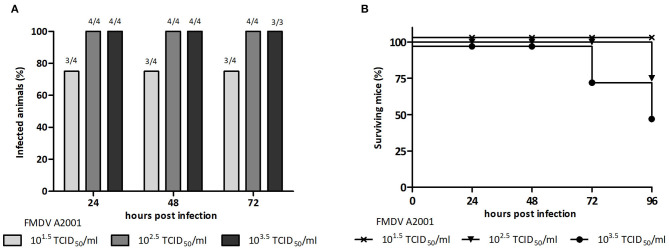
Selection of the infective dose of FMDV, serotype A. Groups of BALB/c mice (n = 4) were ip inoculated with 500 μL of 101.5TCID50, 102.5TCID50, or 103.5TCID50/mL of infectious FMDV A/Argentina/2001, and viremia was analyzed at 24, 48, and 72 hpi. (A) Percentage of infected animals at 24, 48, and 72 hpi and (B) percentage of surviving mice at 24, 48, 72, and 96 h after inoculation with infective FMDV.